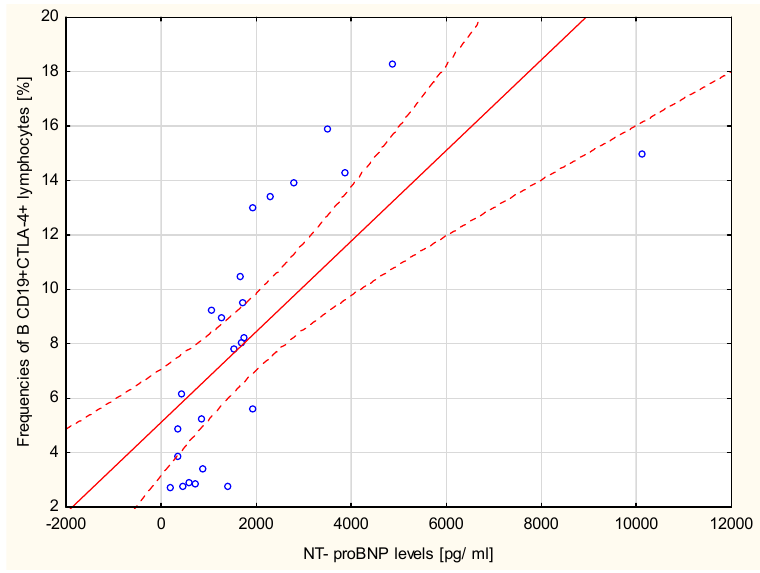
Figure 8. B CD19+CTLA–4+ cells [%] and NT–proBNP concentration [pg/mL]; Spearman’s rank correlation r = 0.8498, p < 0.001.